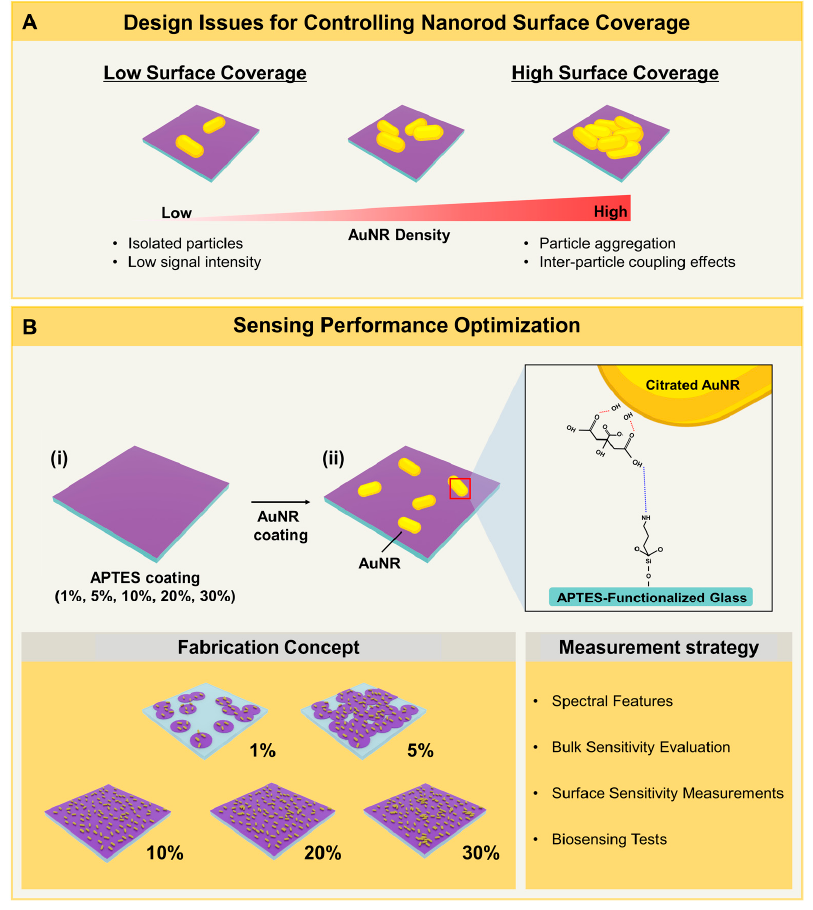
Figure 1. ( A ) Overview of technical considerations for preparing low- and high-coverage AuNR sensing platforms. ( B ) Fabrication concept and measurement strategy to control AuNR platform properties by varying the APTES concentration.